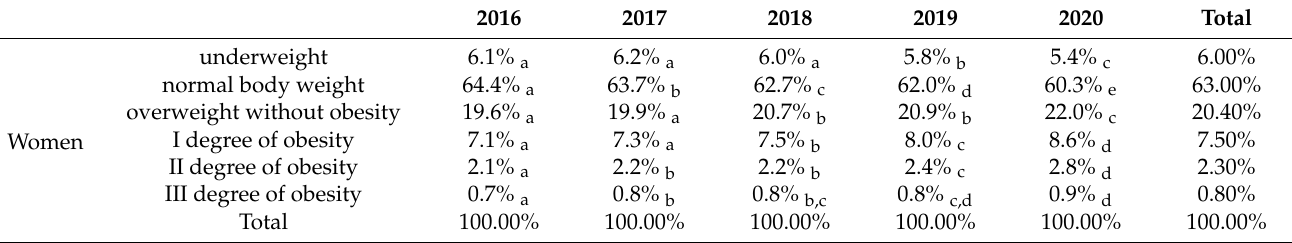
Table 3. Relationship between BMI and measurement time, as well as patients’ sex; data presented as percentage of the year of measurement 1